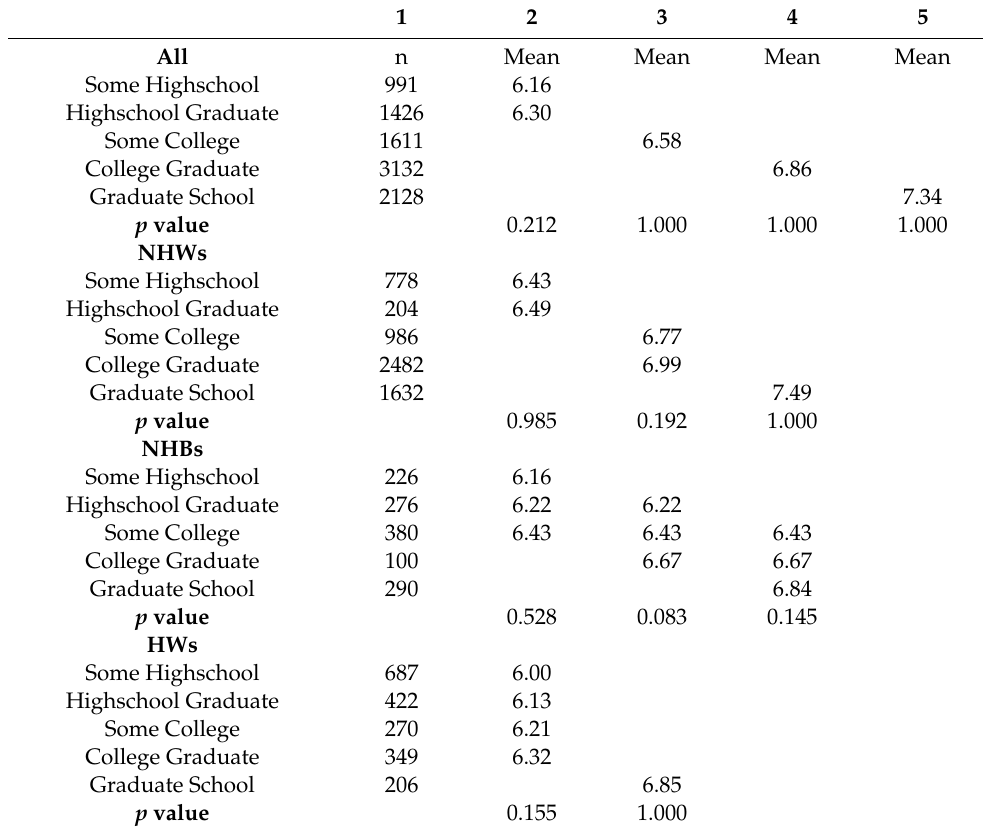
Table 5. Post Hoc test overall and by